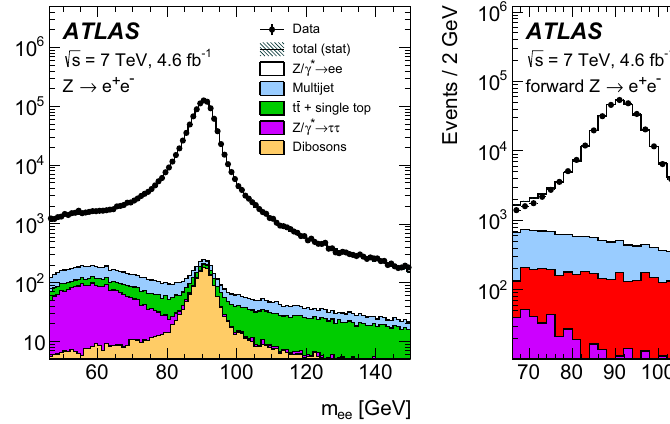
sum of all expected background and signal contributions is shown as a solid line with a hashed band detailing the statistical uncertainty and labelled “total (stat)”. The legend lists only background sources with a visible contribution